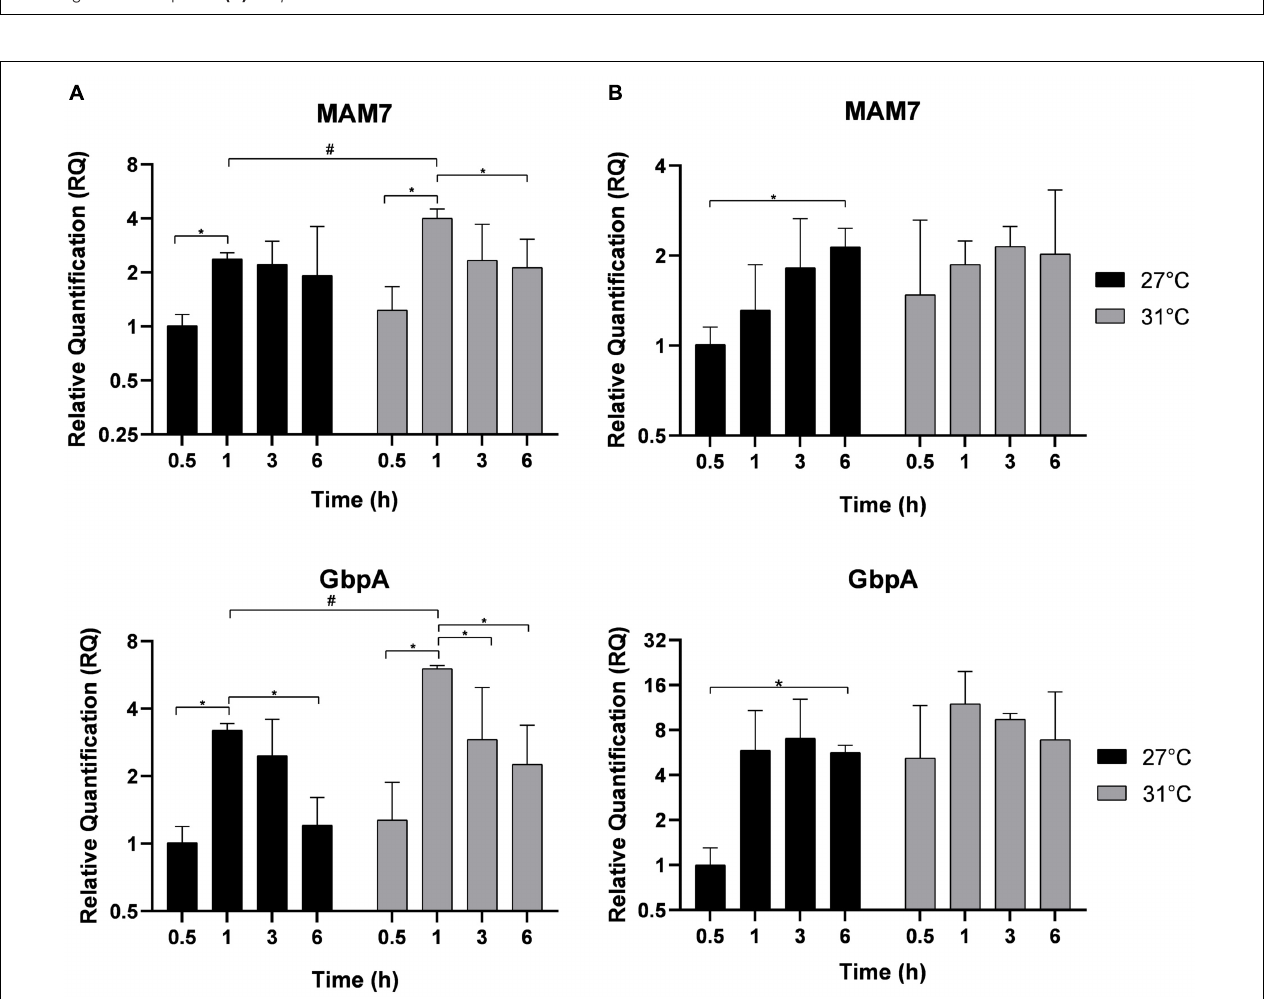
FIGURE 3 | Adhesion genes expression MAM-7 and GbpA in free-living V. parahaemolyticus (A) and adherent bacteria (B) incubated at 27 ◦ C (black) and 31 ◦ C (gray). Bacteria were maintained 0.5, 1, 3, and 6 h in different conditions before RNA extraction from free-living bacteria and adherent bacteria for same well. Relative quantification expressions are expressed as means ± standard deviations of results from experiments performed with three replicate samples. # Significant difference between temperatures. *Significant difference between time points.